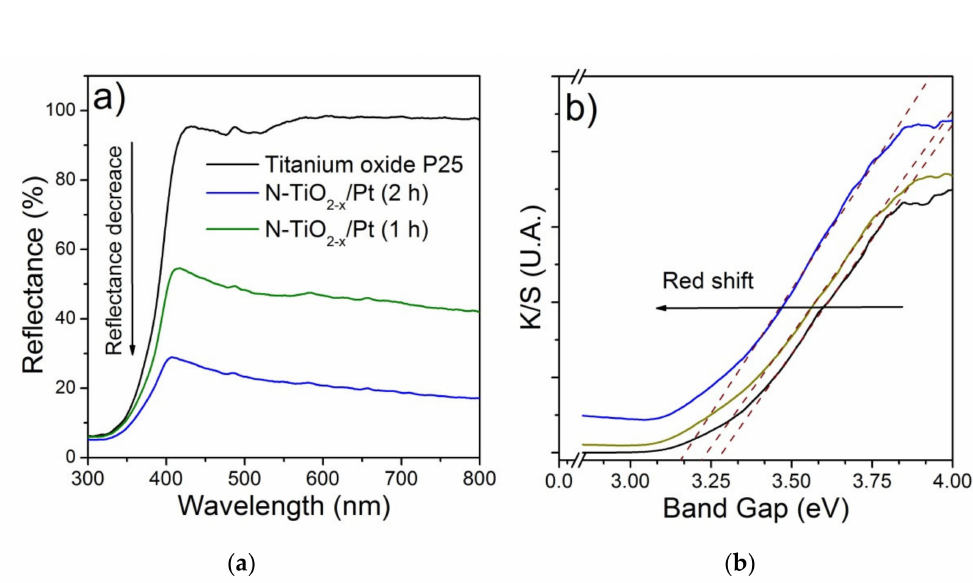
Figure 6. ( a ) DRS spectra and ( b ) absorbance spectra after Pt impregnation in TiO 2